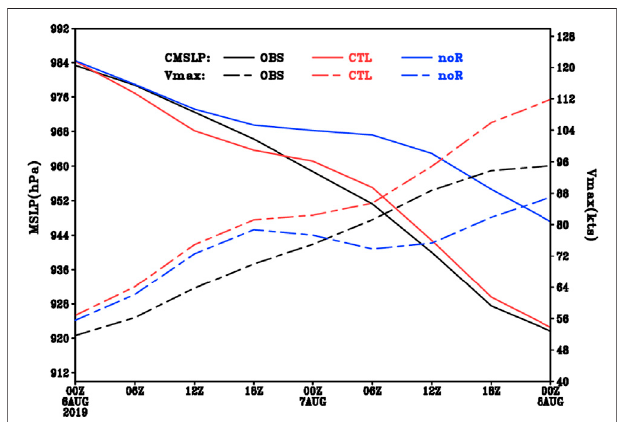
FIGURE 1 | Observed and simulated intensities of Lekima from 00 UTC 06to00UTC08August2019.ThesolidlinesindicatetheCMSLP(units:hPa), and the dotted lines are the maximum wind speed (units: